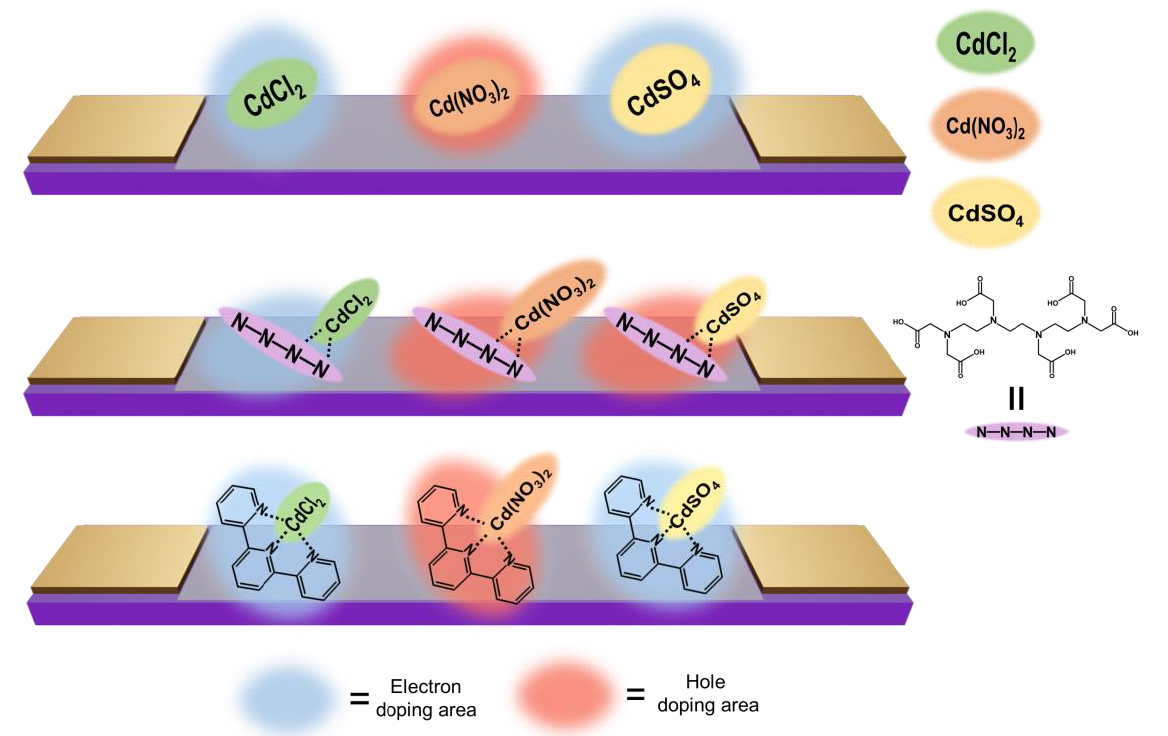
Figure 6. Dependence of the change in drain current on the cadmium concentration in ( a ) pristine, ( b ) TTHA-modified, and ( c ) terpyridine-modified graphene-based sensors.